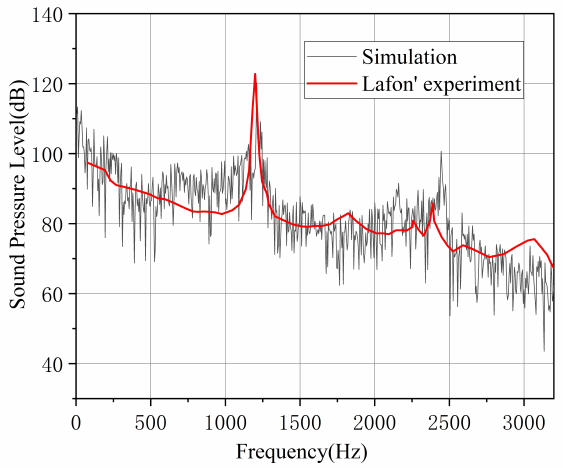
Figure 5. Comparison of the simulation results and Lafon’ experiment data. The black line is simulation results. The red line is Lafon’ experiment data.